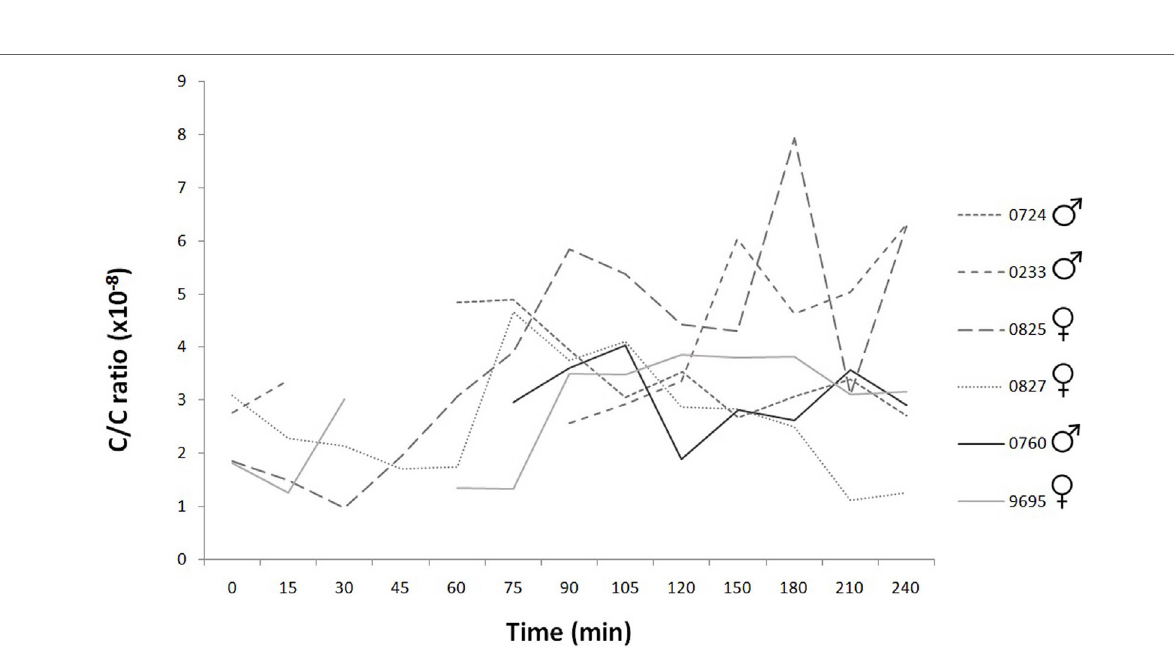
FigUre 4 | Time course of individual cortisol/creatinine ratios during the 240 min. The C/C ratio of healthy dog is under 10 × 10 − 6 . The values did not exceed this limit during the examination period in any